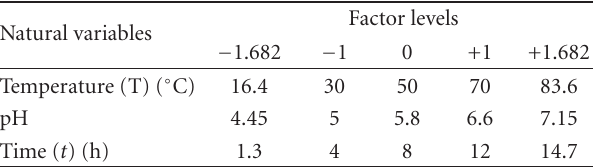
Table 1: Natural variables and factor levels. Coded variables: X 1